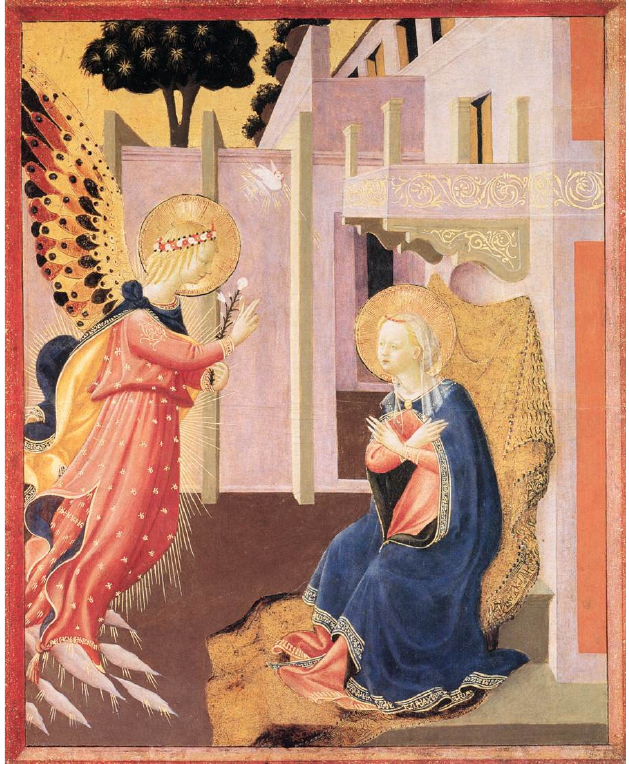
Figure 8. Zanobi Strozzi, The Annunciation , c. 1453, The Philadelphia Museum of Art, PA. It suits our purposes to highlight in this painting the high wall that closes off the vast courtyard (an analogy of “garden”). It sounds evident that, through this high wall, Strozzi seeks to communicate the idea of the hortus conclusus , as a symbol of Mary’s virginal divine motherhood, her perpetual virginity, and the fullness of her sublime virtues and privileges, as the medieval liturgical hymns celebrate.